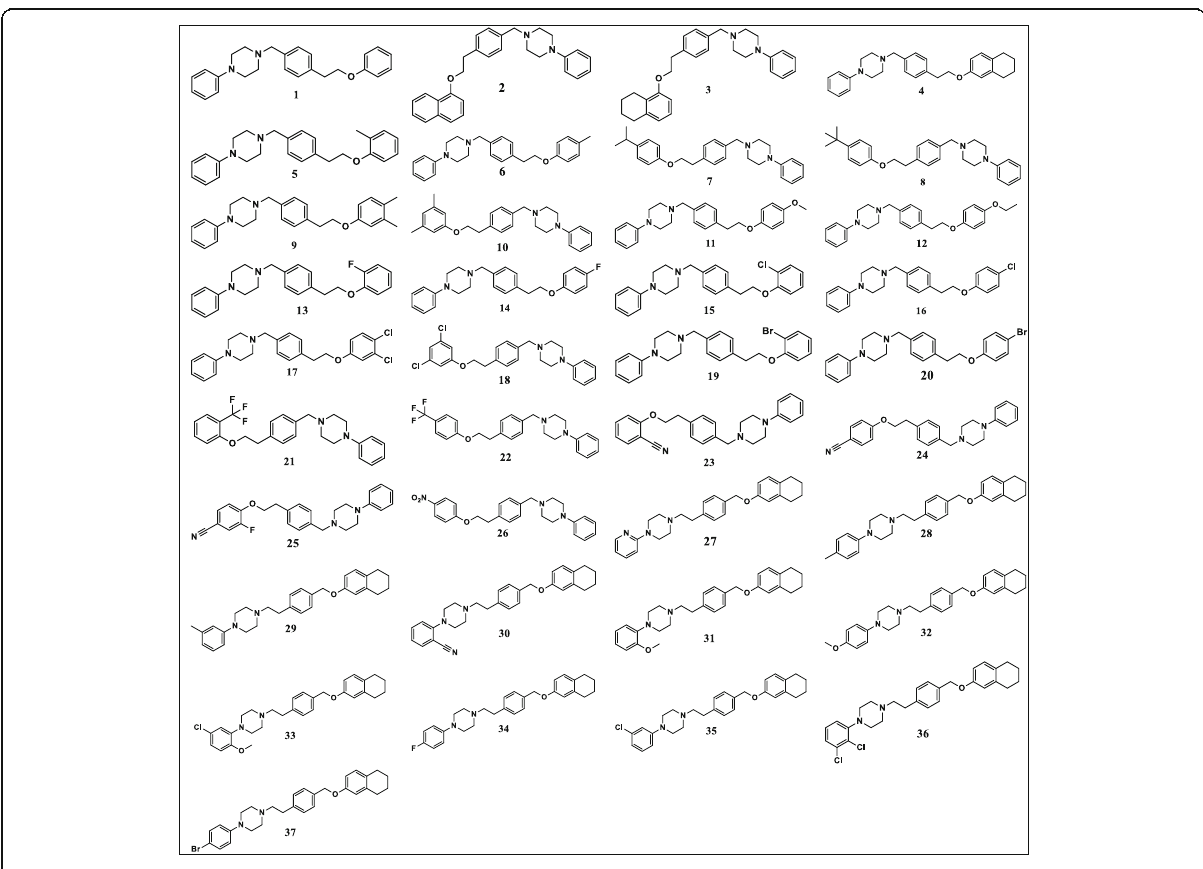
Fig. 1 2D structures compounds used in QSAR